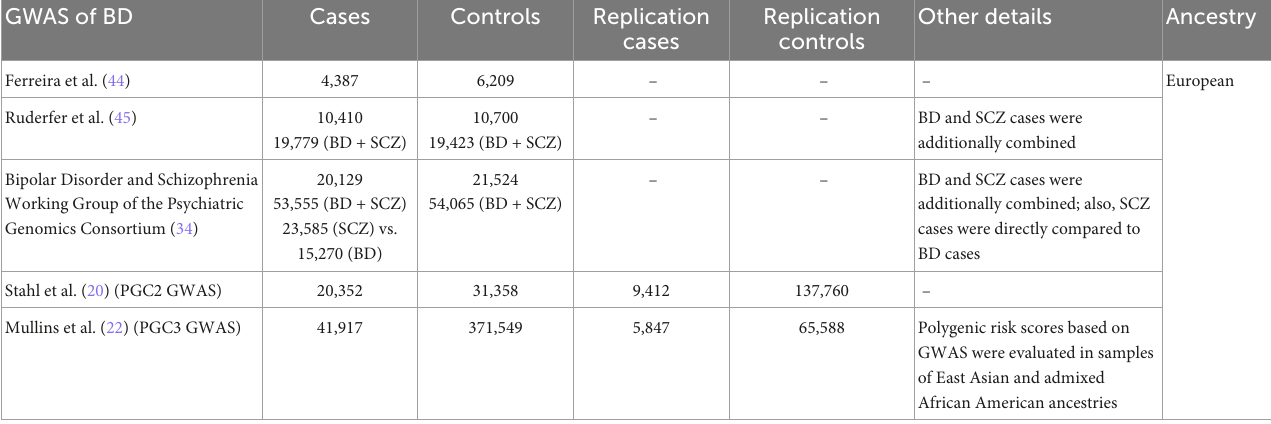
TABLE 1 Genome-wide association studies (GWASs) used in the functional studies that investigated epigenetic alterations in bipolar disorder (BD). GWAS of BD